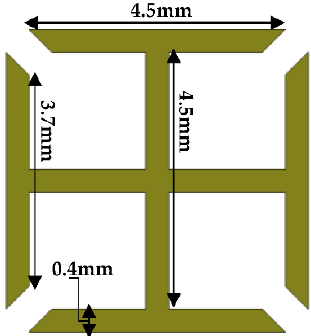
Figure 5. Metallic-Cross MTM unit-cell structure.